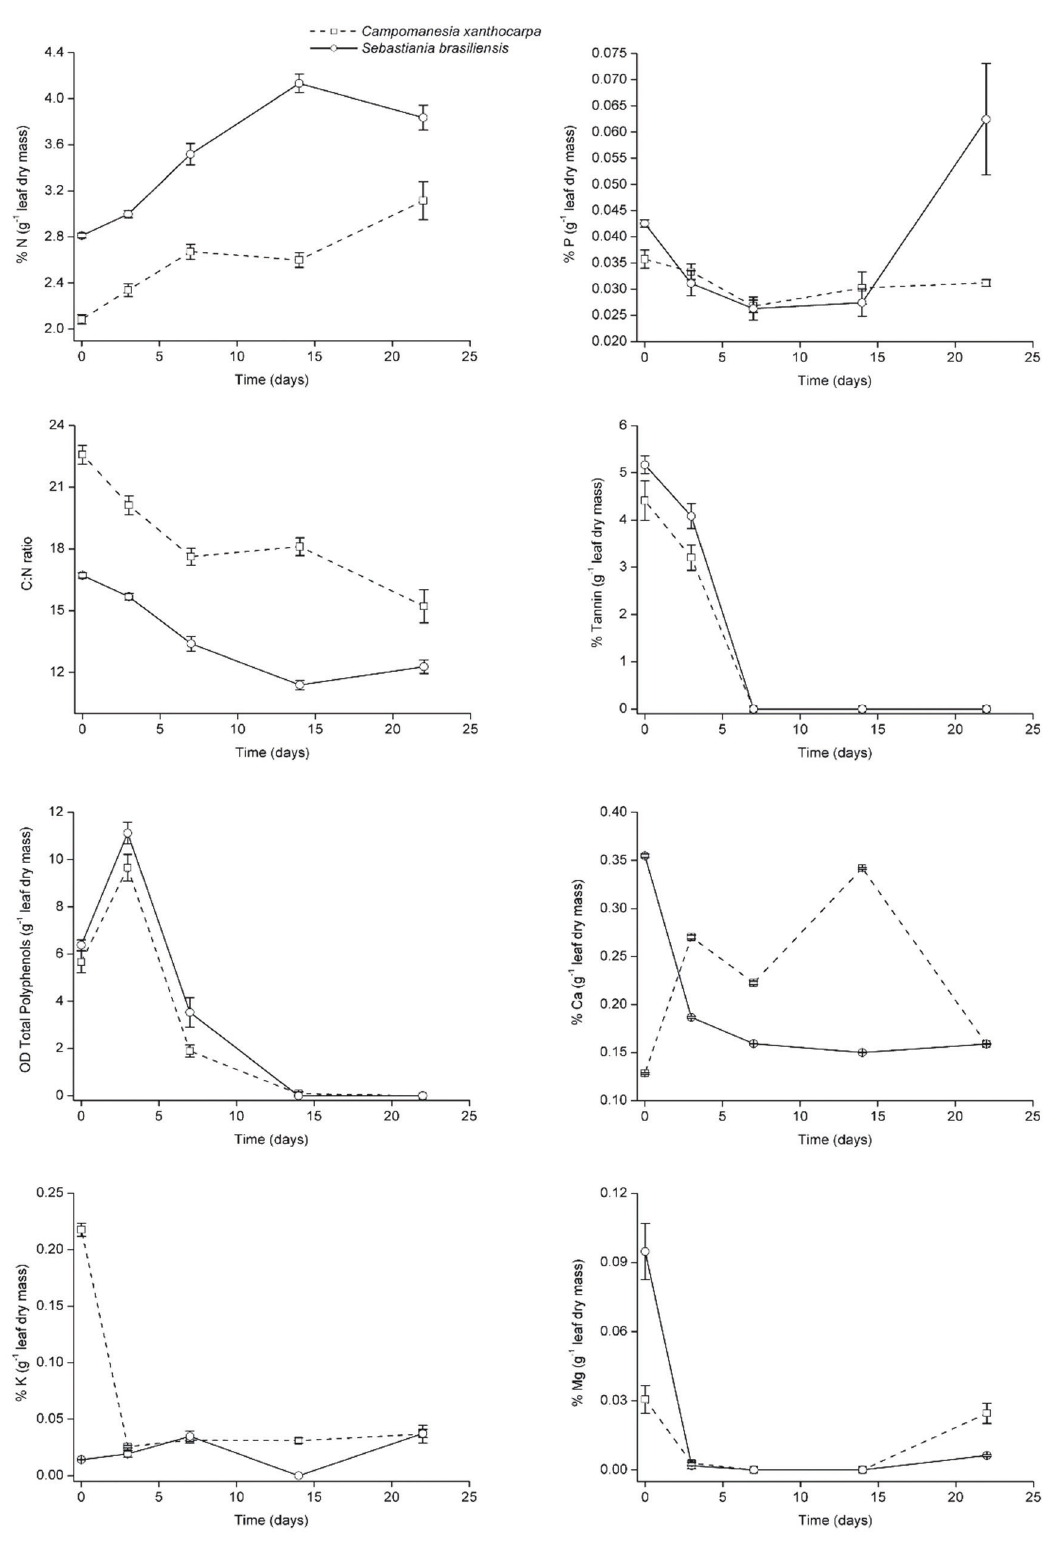
Figure 1. Temporal variations of chemical compounds of leaves of tree species in a subtropical stream. OD = optical